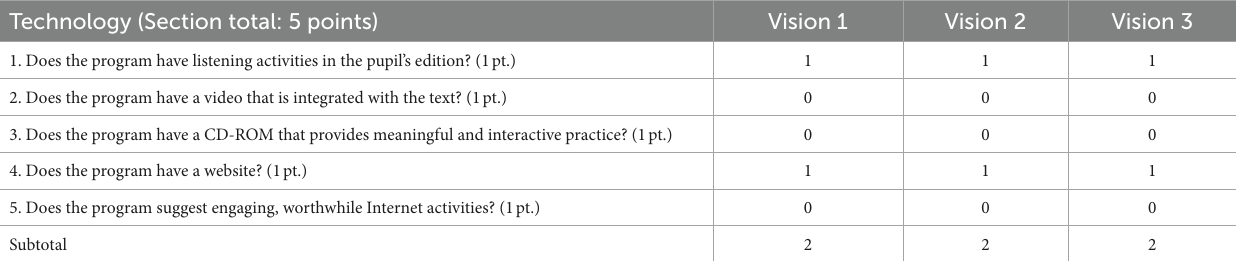
TABLE 7 Evaluation of Vision Series technology according to ACTFL. Technology (Section total: 5